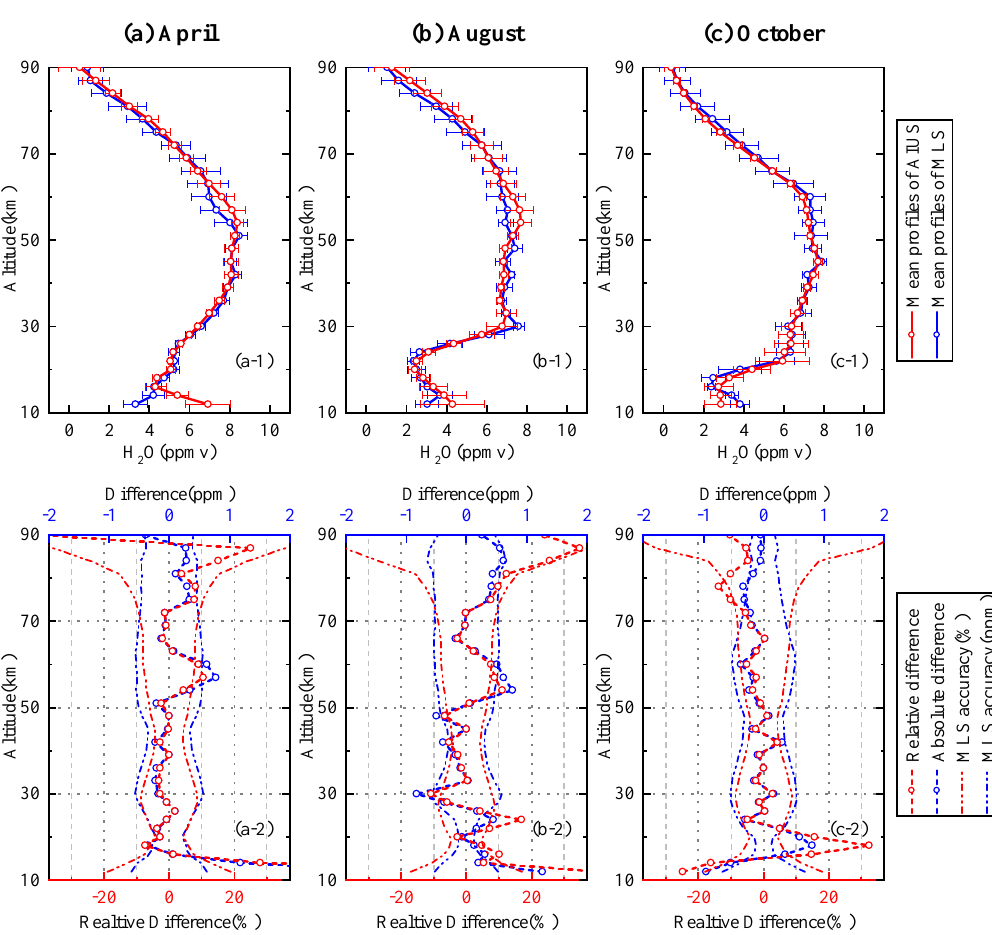
Figure 15. Same as Figure 12 except for 75 ◦ –80 ◦ S in April, August, and